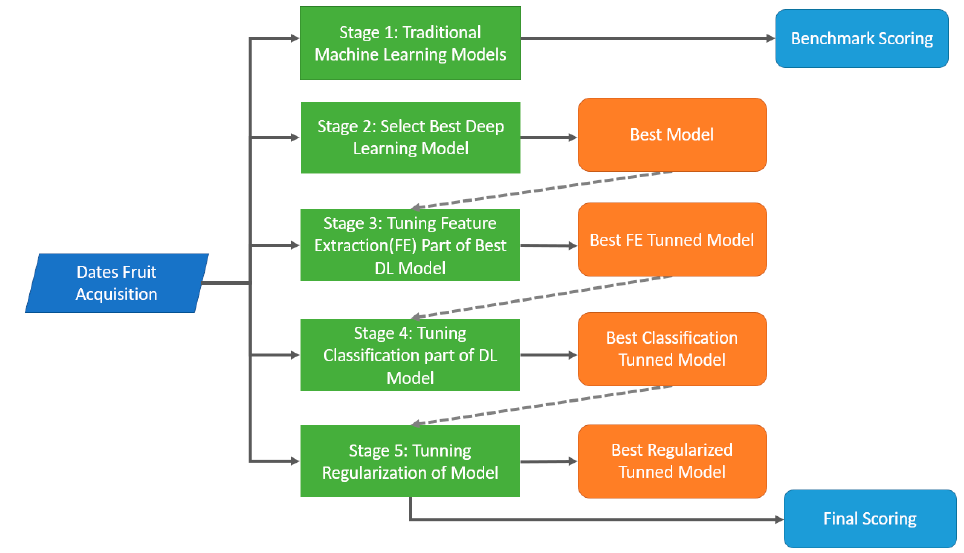
Figure 2. Proposed model flowchart.